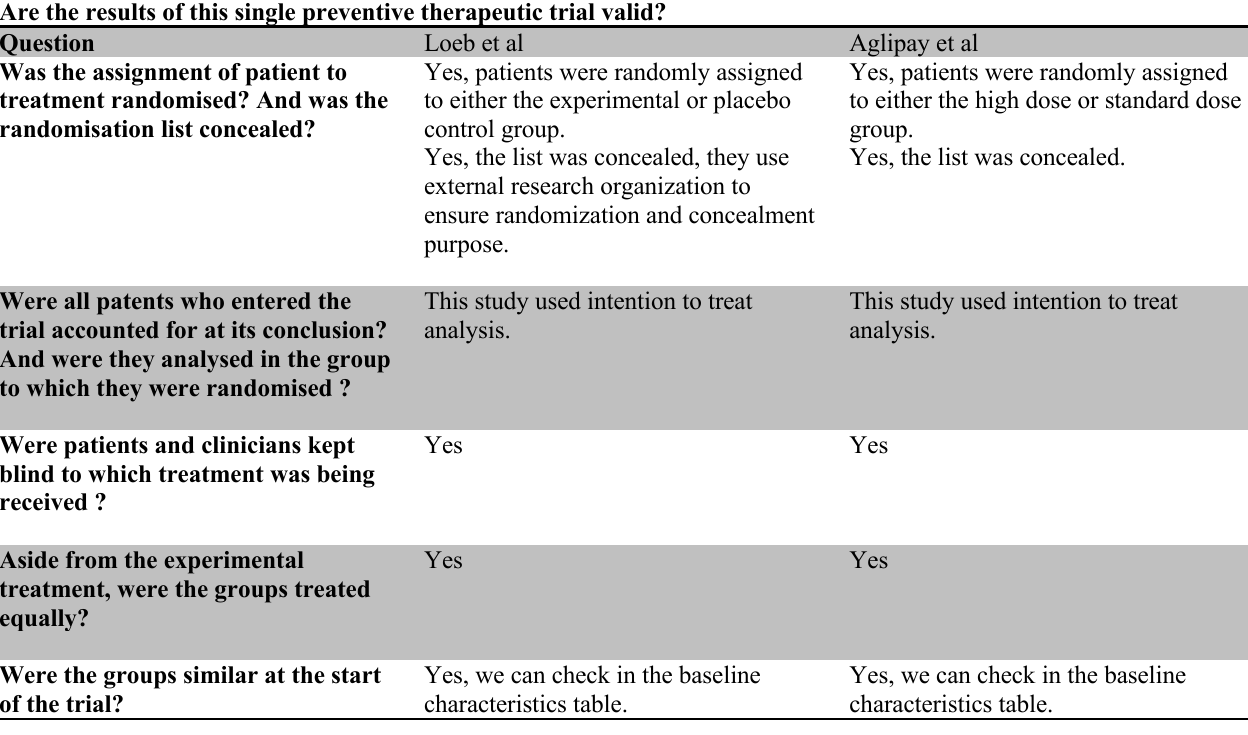
Table 3. Validity Assessment for RCTS by Loeb et al and Aglipay et